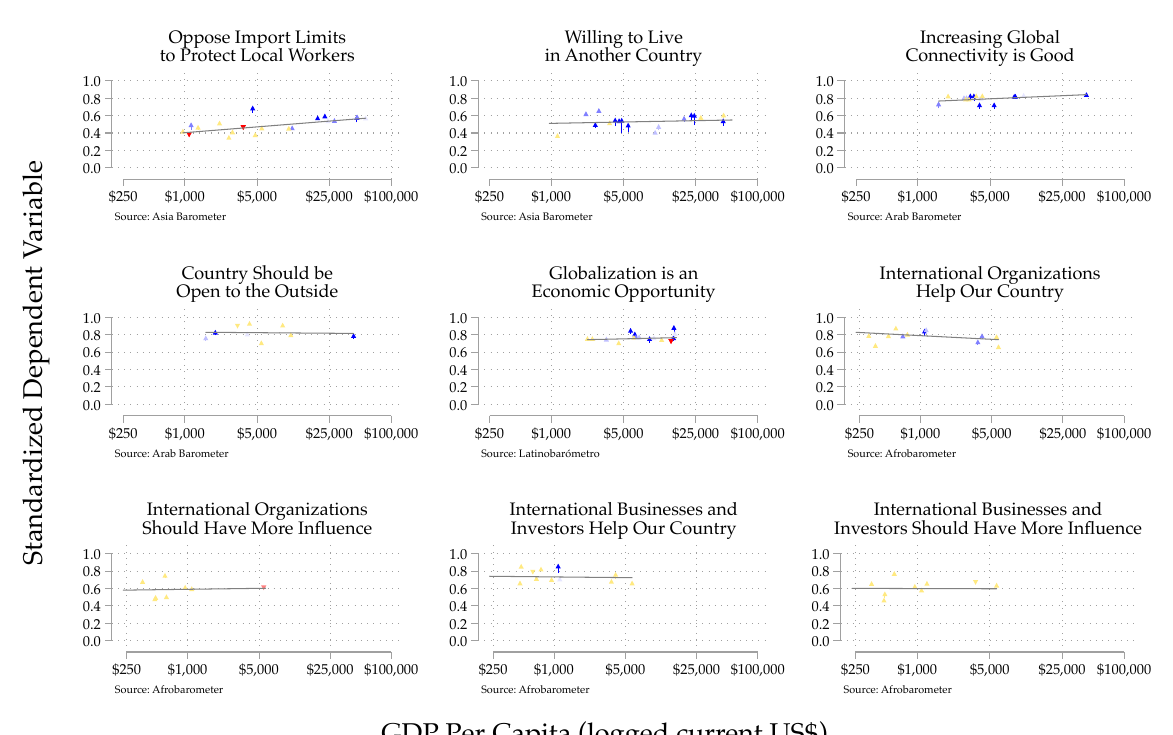
Figure 2: Quiver plots illustrating the effect of urban professional elite status on cooperative-internationalist attitudes using results of country-wave level regressions on regional survey data. Note: This figure displays results of 171 individual linear models regressing urban professional elite status on each dependent variable for each country-wave in the regional surveys. The gray fit line tests H1 by illustrating the relationship between GDP per capita and the mean value of each dependent variable (scaled to range from 0-1) for each country-wave. Colored arrows test H2 and H3, with standardized regression coefficients on the y axis indicating the proportion change in the dependent variable associated with urban professional elite status in each country-wave. Blue arrows indicate positive and significant coefficients, red arrows indicate negative and significant coefficients, and yellow arrows indicate coefficients that do not achieve statistical significance at the p < 0.05 level. Darker shades indicate smaller p